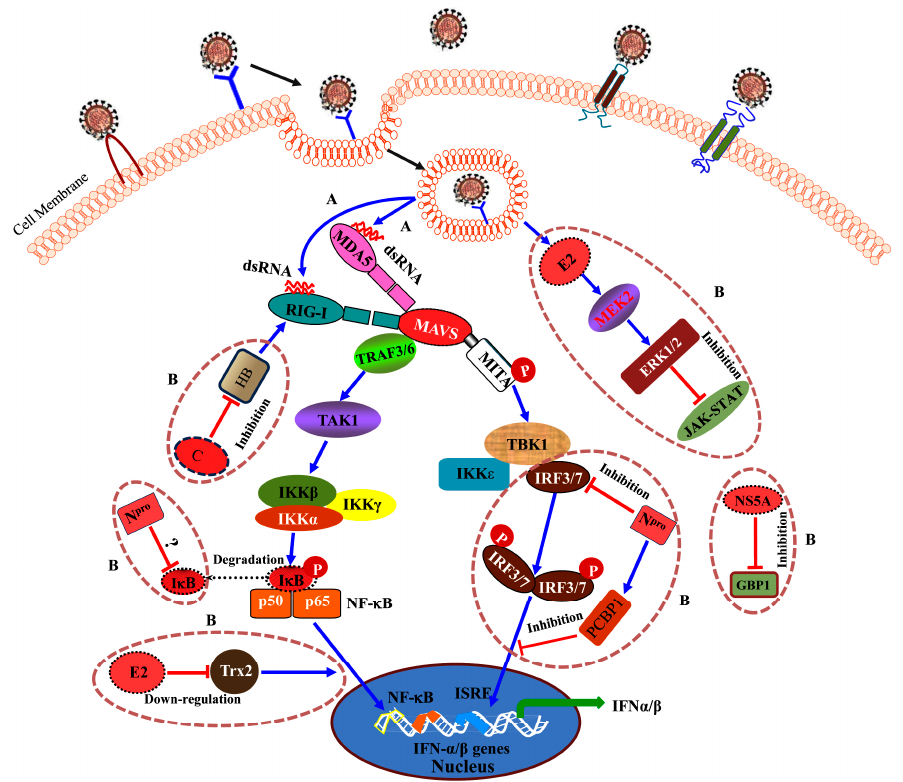
Figure 4. Activation and blockage of the intracellular signaling pathways of innate immunity during CSFV infection. ( A ) CSFV RNA is sensed by melanoma differentiation-associated protein 5 (MDA-5) and retinoic acid inducible gene I (RIG-I). ( B ) CSFV blocks the host innate immunity through multiple steps.